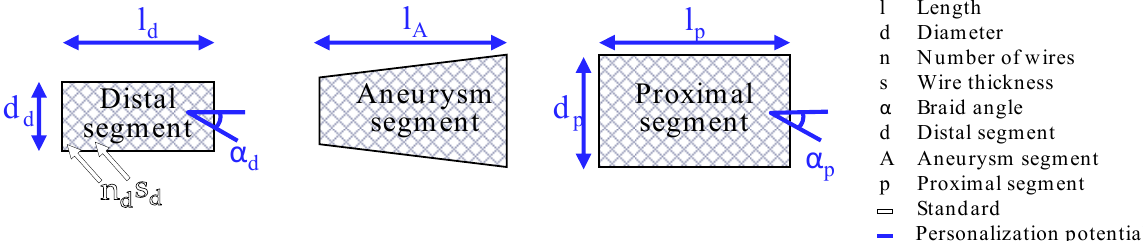
Figure 11. Segments of the flow diverter with product characteristics and their relevance for personalization.